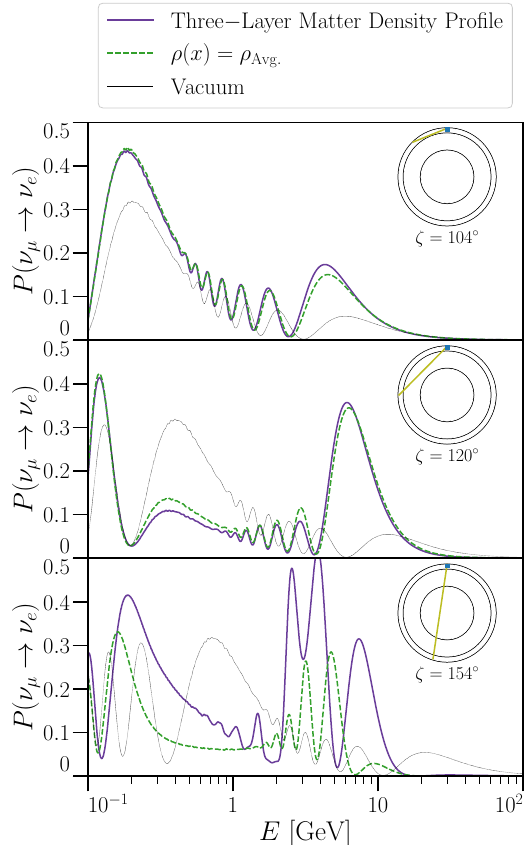
Figure 8 . Oscillation probability P ( ν µ → ν e ) for three different zenith angles, cos ζ = − 0 . 25 (top panel), cos ζ = − 0 . 5 (middle panel) cos ζ = − 0 . 9 (bottom panel) assuming the three-layer mass den- sity profile (MDP) (violet), the average density on the trajectory (dashed green), and vacuum